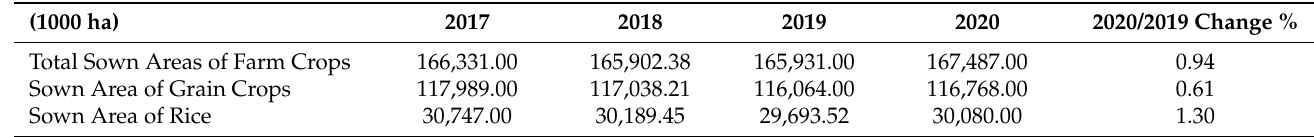
Table 4. Sown area changes.